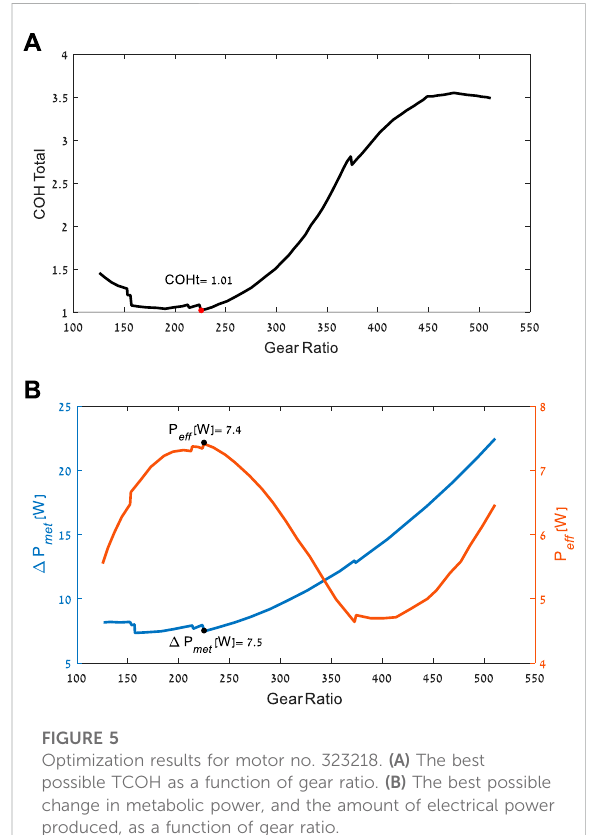
FIGURE 5 Optimization results for motor no. 323218. (A) The best possible TCOH as a function of gear ratio. (B) The best possible change in metabolic power, and the amount of electrical power produced, as a function of gear ratio.